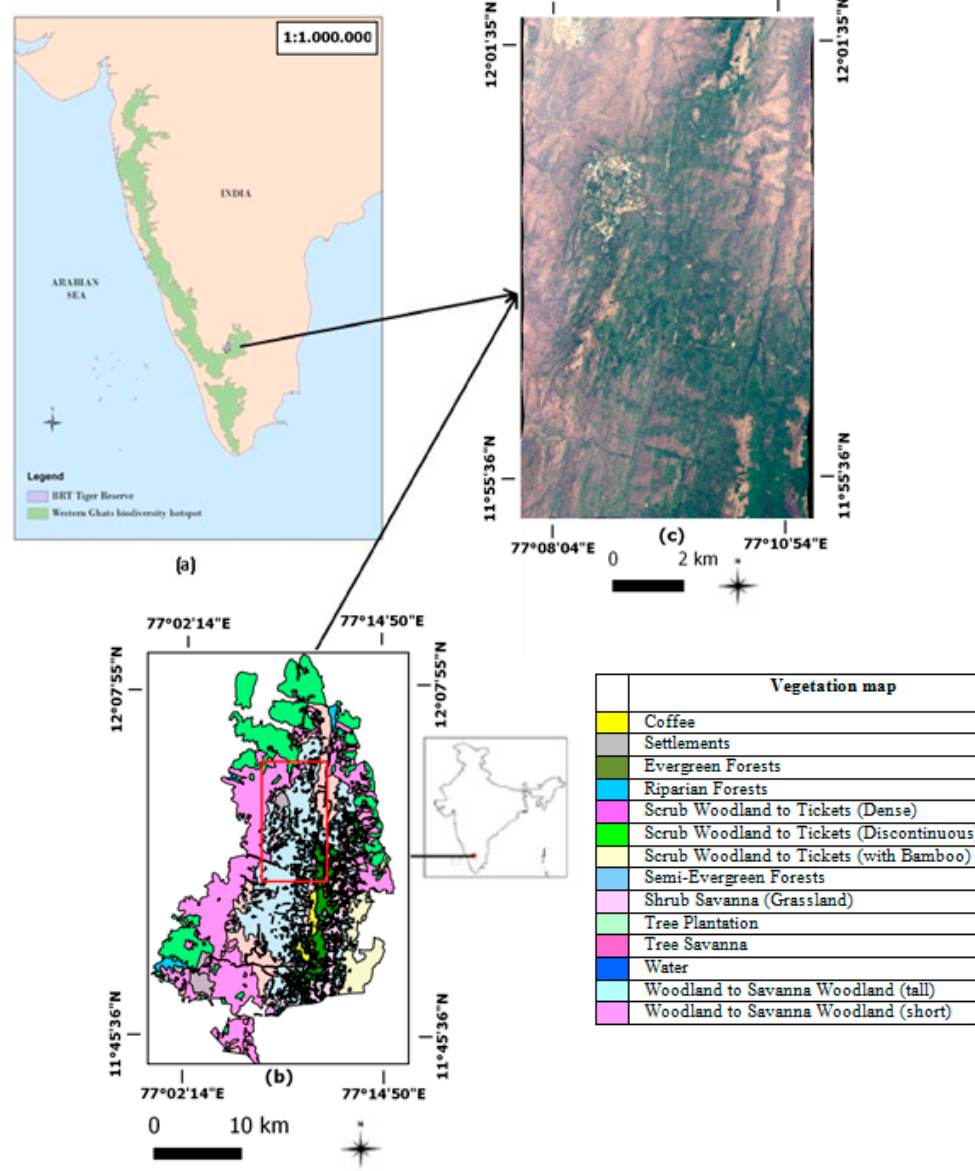
Figure 2. ( a ) Biligiri Rangaswamy Temple Tiger reserve location; ( b ) existing LC/LU map dated 1998, where the red rectangular area is monitored by the WorldView-2 image; and ( c ) WorldView-2 image, 2 m resolution, 14 March 2013. True Colour Composite: R = 5, G = 3, B = 2.